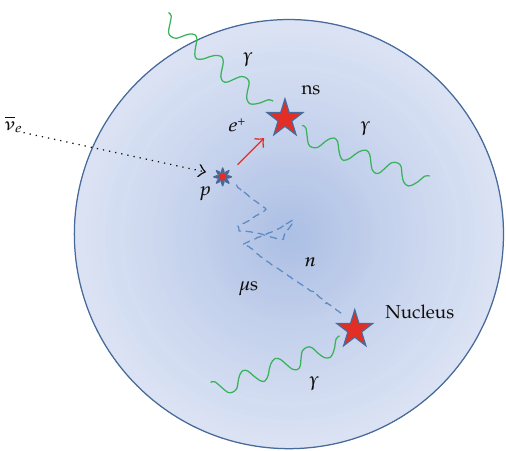
Figure 6: Schematic of antineutrino detection by scattering on protons. Prompt signal comes from positron annihilation, delayed signal occurs when neutron captures a